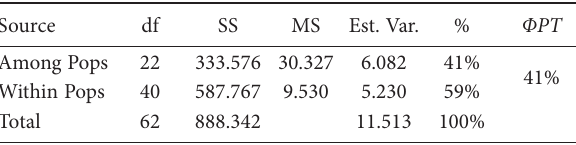
Table 5. Analysis of molecular variance (AMOVA) of the studied species.